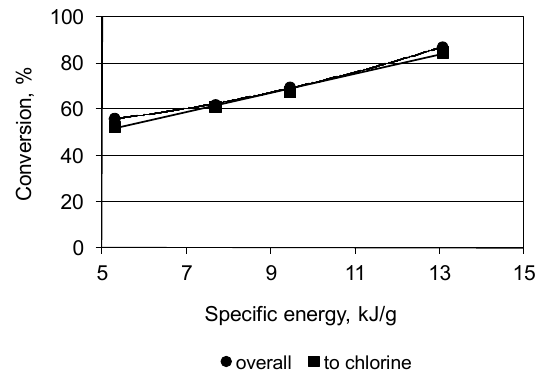
conversion and specific 4